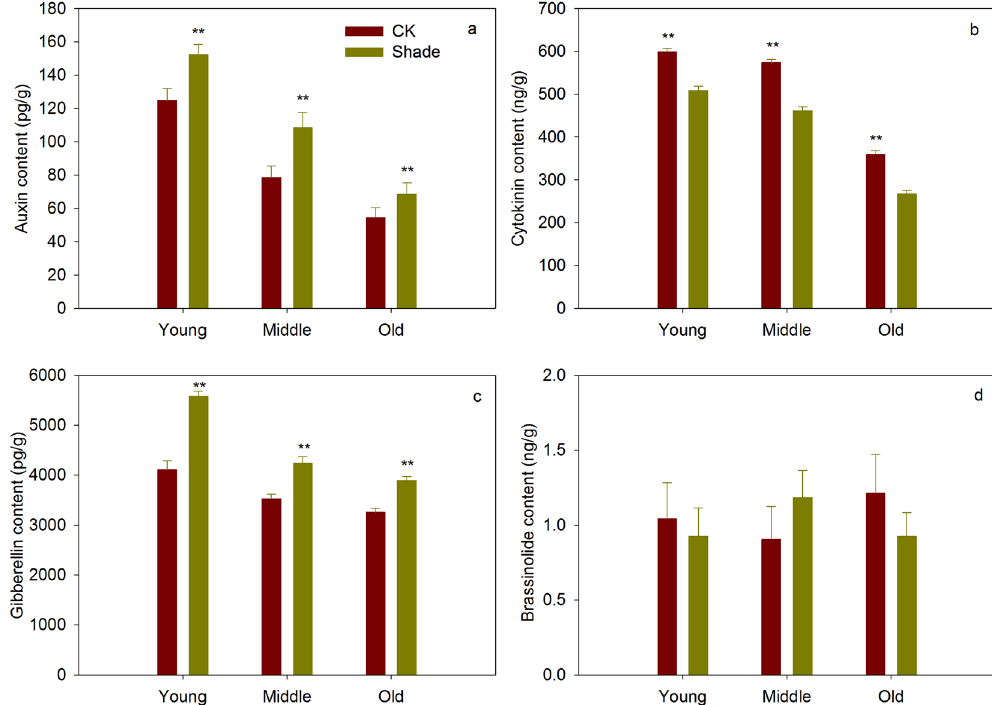
Figure 7. Hormones content (auxin ( a ), cytokinin ( b ), gibberellins ( c ), and brassinolide ( d )) of soybean planted in shade and full sunlight (CK). Values are means ± SD (n = 6). Statistical significance assessed by Duncan’s t-test. * and ** indicates significant at 0.05 and 0.01 probability level, respectively.